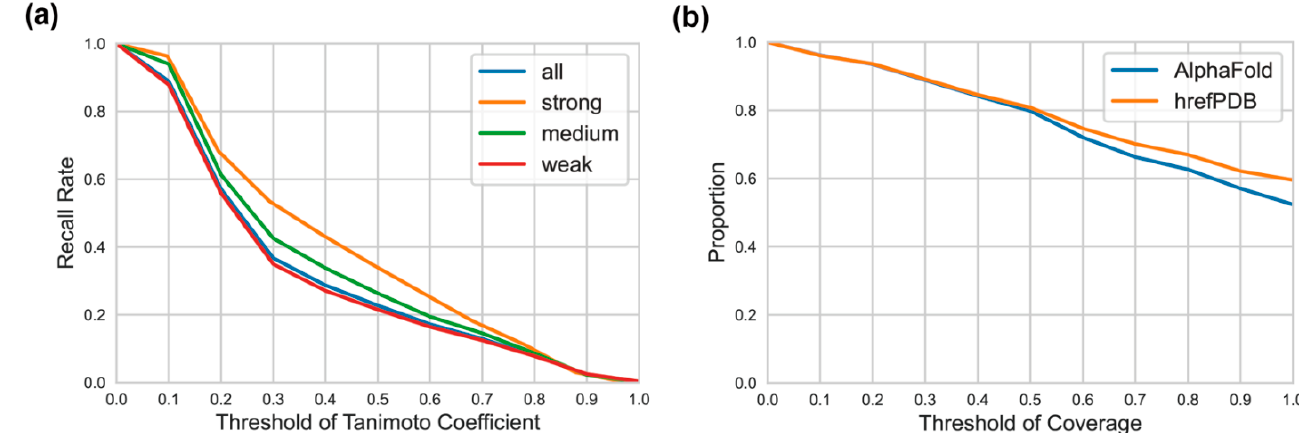
Figure 4. ( a ) The recall rate of hrefPDB cavities at different Tc thresholds. ( b ) The proportion of true ligand binding sites recovery under different thresholds of residue coverage for both hrefPDB structures and AlphaFold structures. The threshold of residue coverage means how many true binding site residues were included in one of the CAVITY detected binding sites.